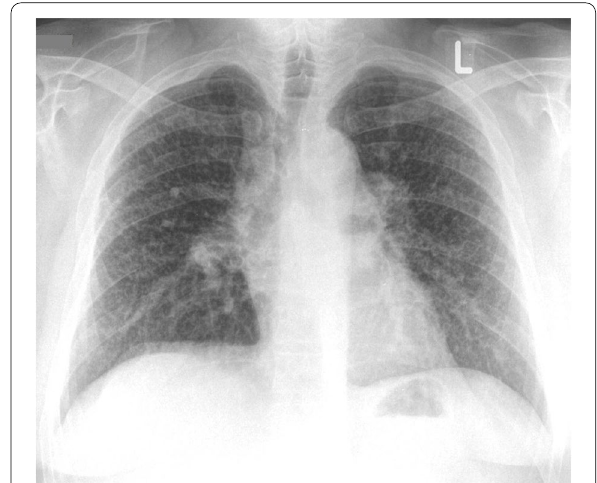
Fig. 1 Chest radiograph showing reticular opacities and cysts in both upper and mid zones and preservation of lung